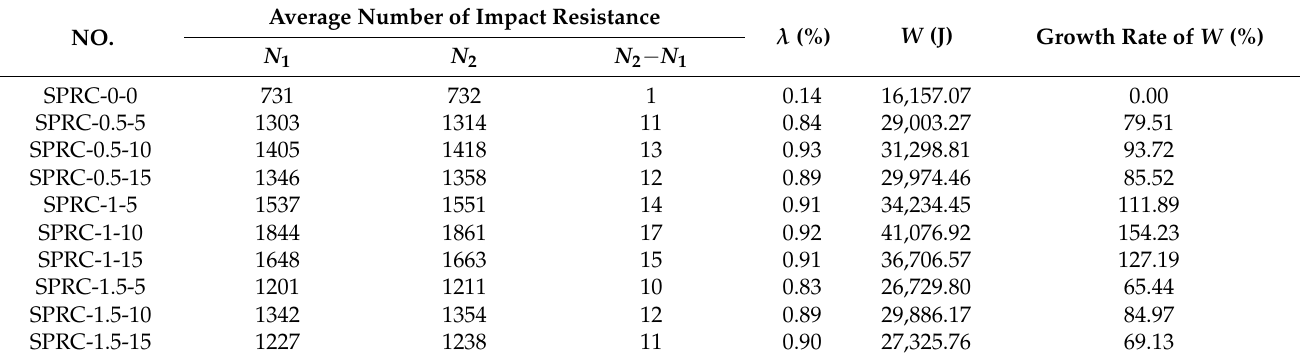
Table 4. Impact resistance index analysis